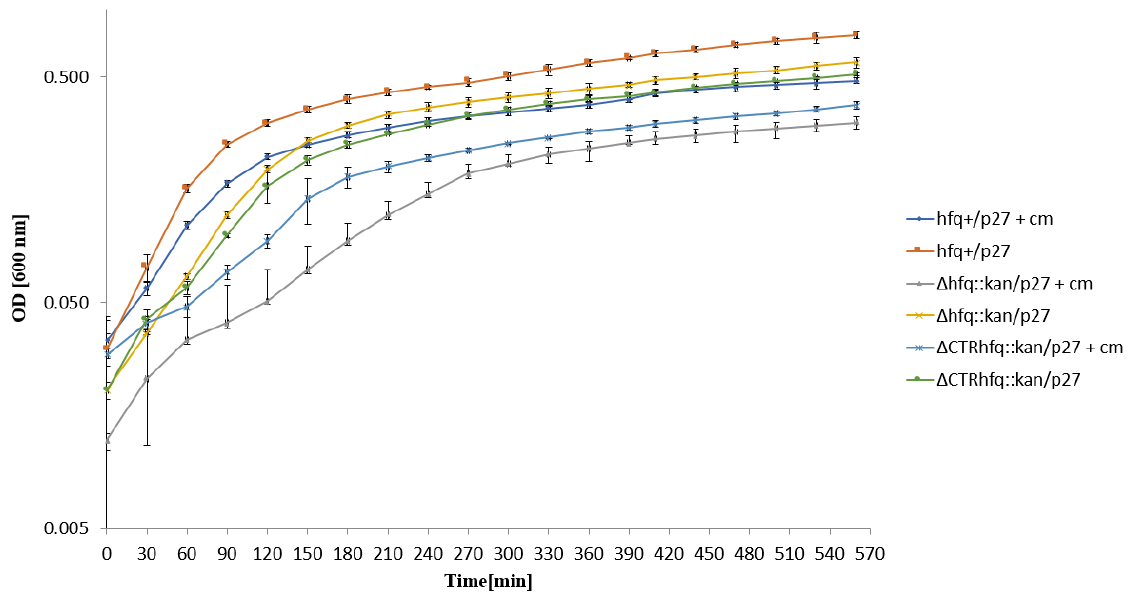
Figure 4. Growth of E. coli strains hfq + , ∆ hfq :: kan , and ∆ CTR hfq :: kan bearing plasmid p27cmr (marked as p27) in the LB liquid medium containing 204 µ g/mL chloramphenicol (+cm) or devoid of this antibiotic (no mark) at 37 ◦ C, after transferring bacteria from antibiotic-free LB and diluting the culture 10 times in a fresh LB medium (with or without chloramphenicol) at time 0. The presented data indicate mean values from three independent experiments with error bars showing SD. Minimal inhibitory concentrations (MIC) of chloramphenicol for hfq + , ∆ hfq :: kan , and ∆ CTR hfq :: kan hosts bearing p27cmr under these conditions were >2048, 1024, and 1024 μ g/mL, respectively.